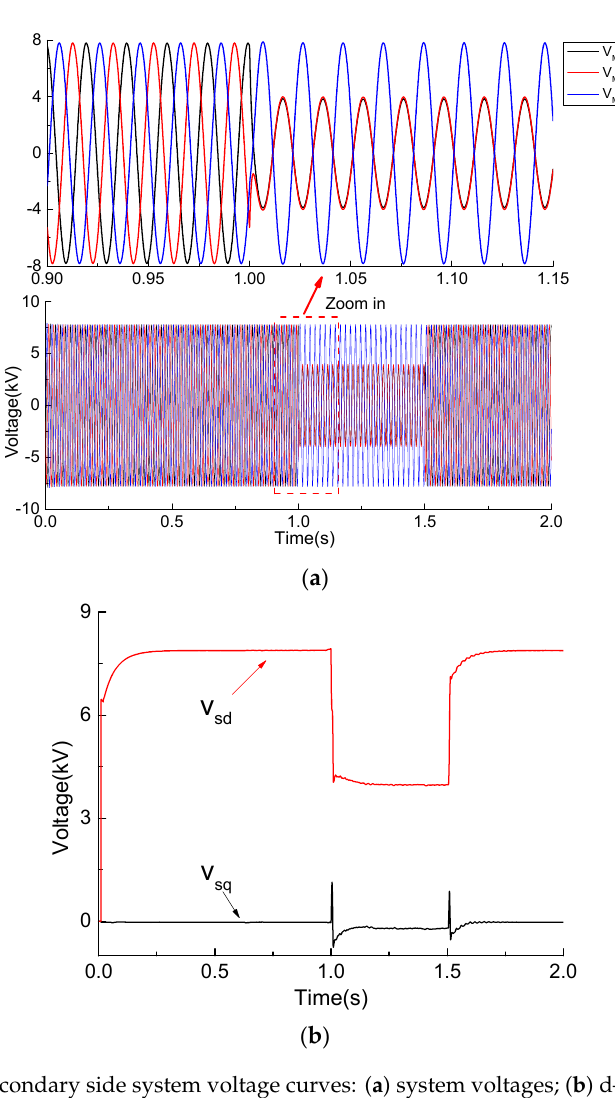
Figure 12. Primary side system voltage curves: ( a ) system voltages; ( b ) d–q waveforms.